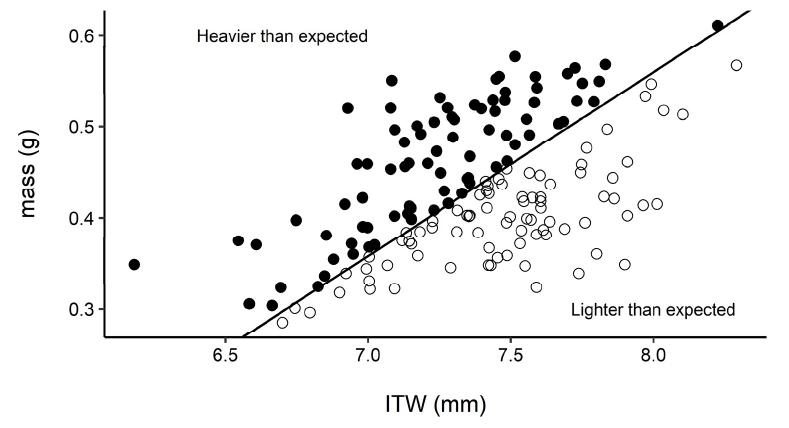
Figure 2. Body mass generally tracks intertegular width for bumble bee queens, with variability in mass at a given ITW indicative of body condition. Queens above the SMA regression line (R 2 = 0.249) were heavier than expected (solid circles) and those below were lighter than expected (empty circles) given exoskeletal size fixed at eclosion. ITW measurements were only available for 2021. We confirmed that mass, ITW, and body condition (BeeMI) did not deviate strongly from normality by visual inspection of residuals, Q-Q plots, and histograms. To account